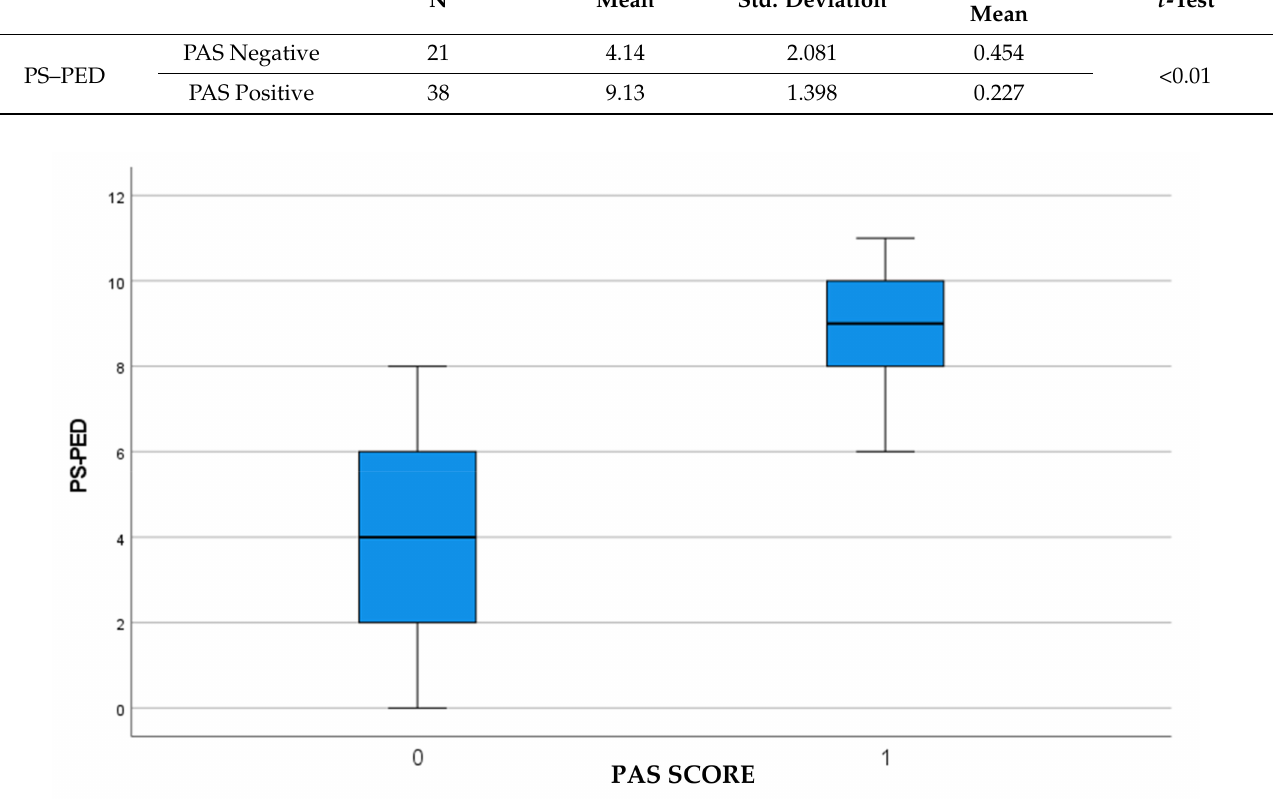
Figure 4. PS-PED score distribution according to PAS score: 0—Negative score for swallowing disorders; 1—Positive score for swallowing disorders